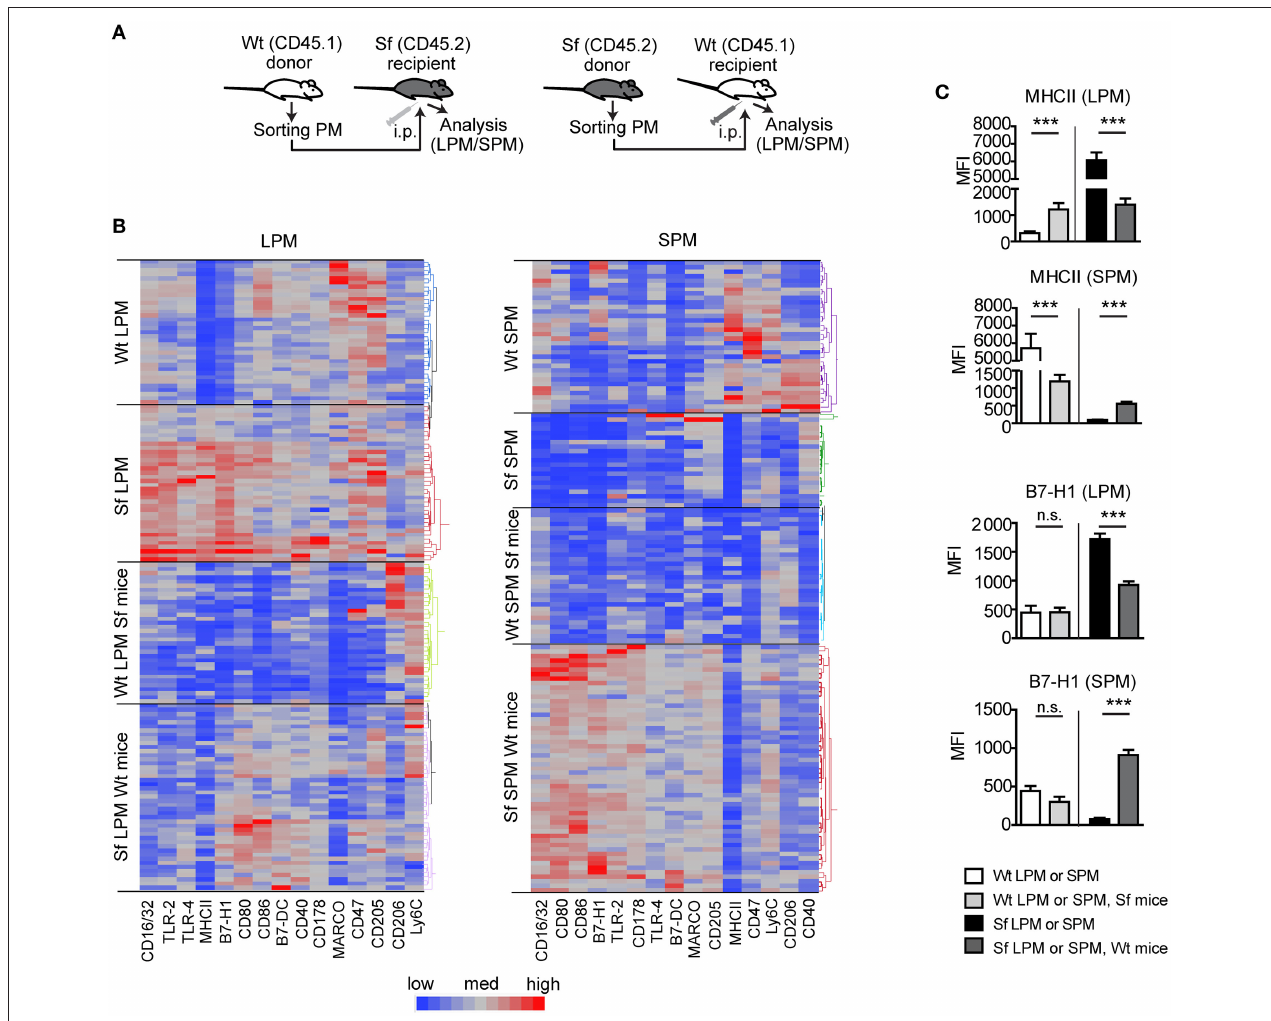
FIGURE 7 | Microenviroment shapes immune signatures of large and small peritoneal macrophages. (A) Schematic outline of the experimental protocol and (B,C) immunophenotyping by single-cell chipcytometry of control (Wt) and scurfy (Sf) large and small peritoneal macrophages (LPM and SPM), isolated from either non-treated mice or following PM transfer to Sf and Wt mice, respectively. Data are depicted as MFI for each surface marker expressed by single cells and shown as heatmap (B) or bar graphs (C) . n = 28–62 cells per experimental group, each sample contains pooled cells from more than 8 donor mice. Statistical analyses were performed using one-way ANOVA, *** p <